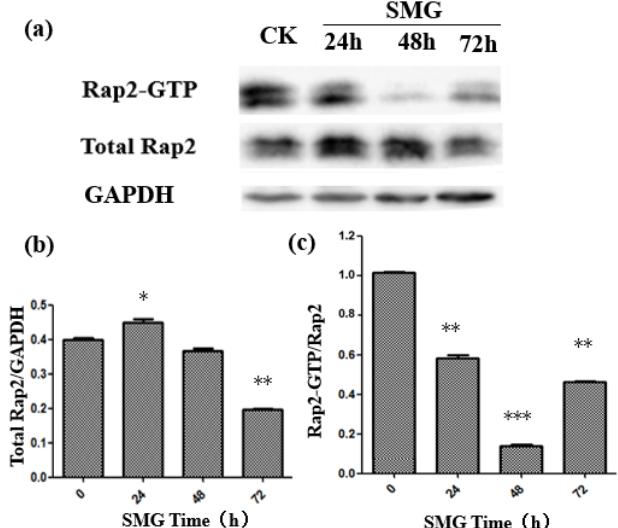
Figure 3. The activation of Rap2 was down-regulated by SMG. ( a ) Expression and activation of Rap2 after different times of SMG treatment were detected by Western blot and GST pull-down assay, respectively. ( b ) The relative Rap2 expression under SMG for 24, 48, and 72 h was calculated based on panel ( a ). ( c ) The relative activation of Rap2 under SMG for 24, 48, and 72 h was calculated based on panel ( a ). The statistical results shown represent the means ( n = 3) vs. the control group ( n = 3); * p < 0.05, ** p < 0.01, *** p <